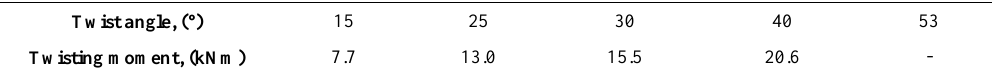
Table 3. Twist angle and torque of torsion bar.